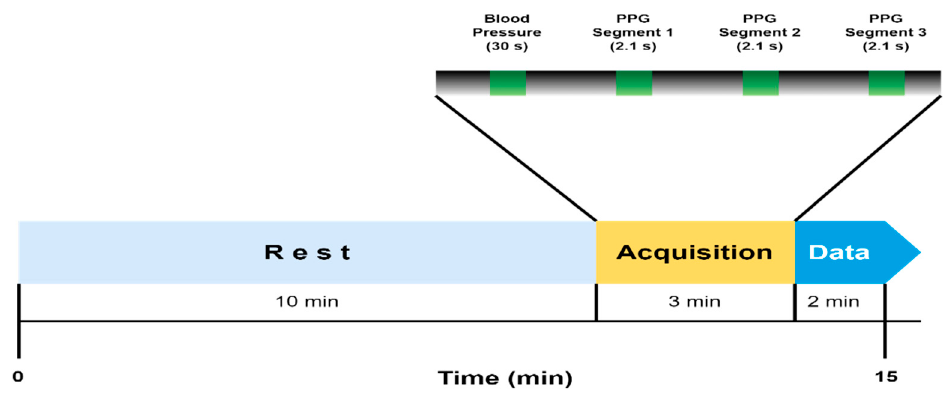
Figure 5. The whole experiment took about 15 min to complete. Each PPG segment lasted 2.1 s, and three were collected per individual.